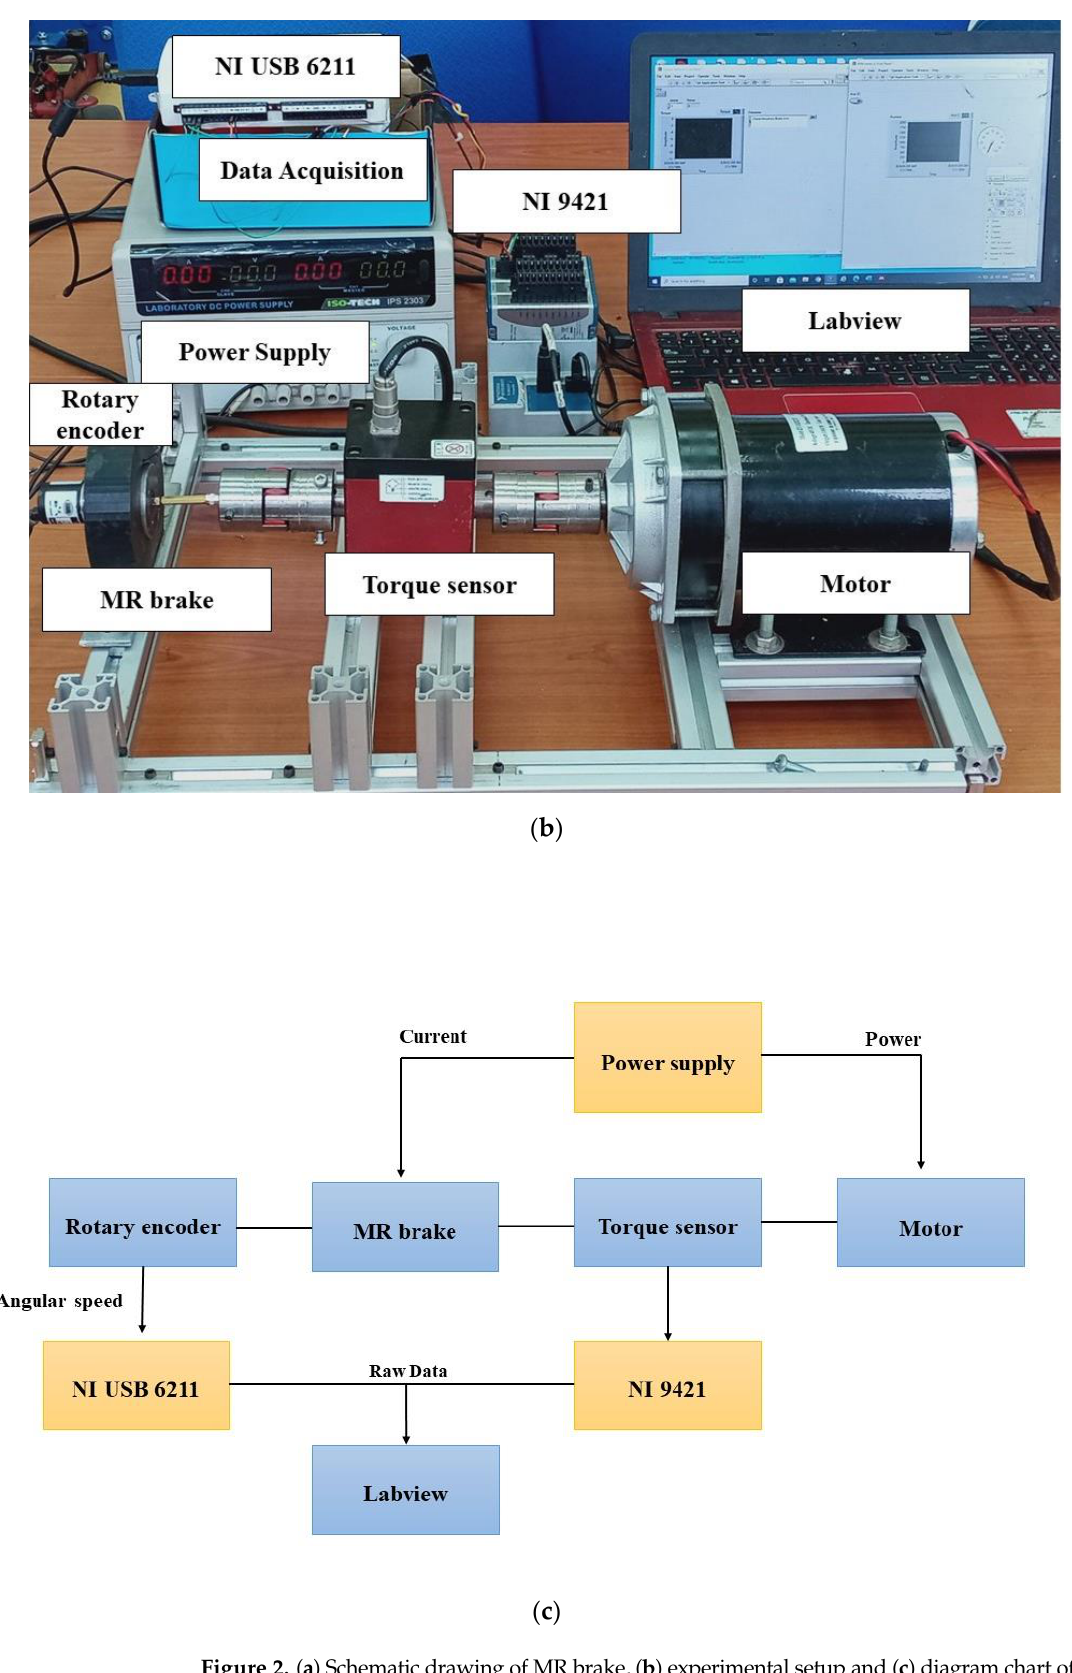
Figure 2. ( a ) Schematic drawing of MR brake, ( b ) experimental setup and ( c ) diagram chart of the test